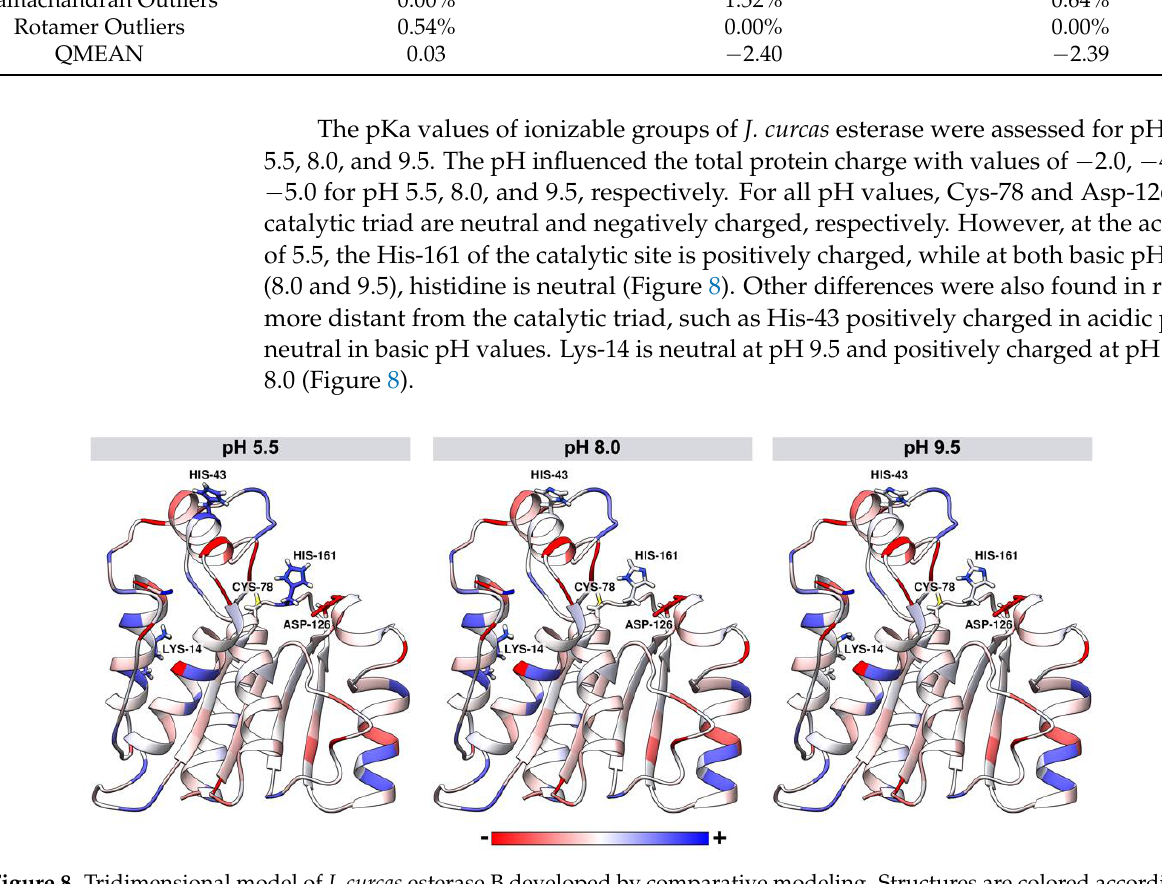
Figure 8. Tridimensional model of J. curcas esterase B developed by comparative modeling. Structures are colored according to the atomic charge for different pH values: 5.5, 8.0, and 9.5. Sticks represent the catalytic triad residues (Cys-78, Asp-126, and His-161) and the residues that had protonation change according to the pH values (Lys-14 and